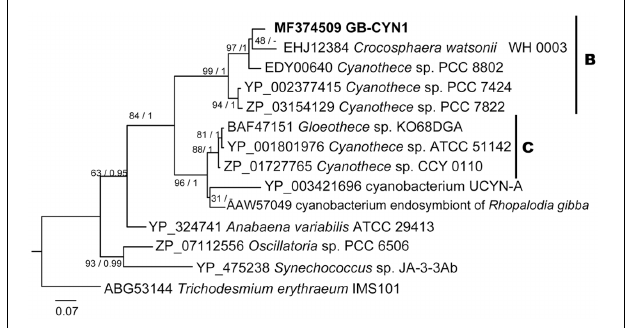
FIGURE 4 | Maximum likelihood and Bayesian NifH phylogenies of GB-CYN1 species and related cyanobacteria. Near-full length NifH amino acid sequence from GB-CYN1 (267aa, from assembled metagenomic contig) was aligned with full length reference sequences. Numbers at the nodes indicate bootstrap values from maximum likelihood analysis (1000 replicates) and the posterior probability of the Bayesian tree inference. The Bayesian consensus tree was concordant with maximum likelihood tree topology except where indicated by a dash. Scale bar represents the mean number of amino acid substitutions per site. The major clades of unicellular cyanobacteria (UCYN-A-C) are labeled according to Zehr et al. (2001), Langlois et al. (2005), and Foster et al.